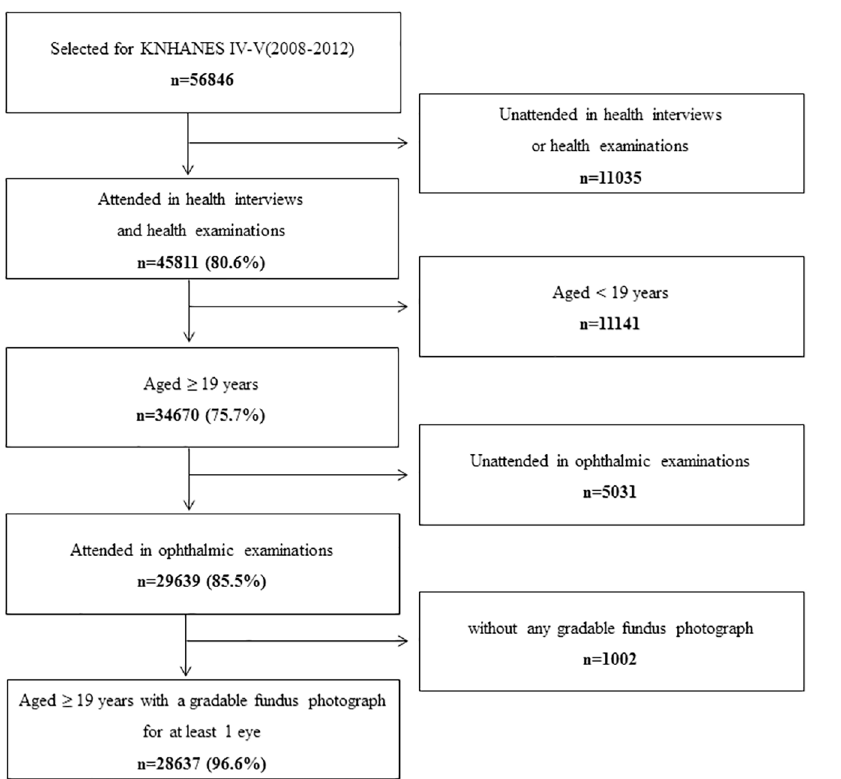
Fig 1. Participation flow chart from the KNHANES2008–2012.